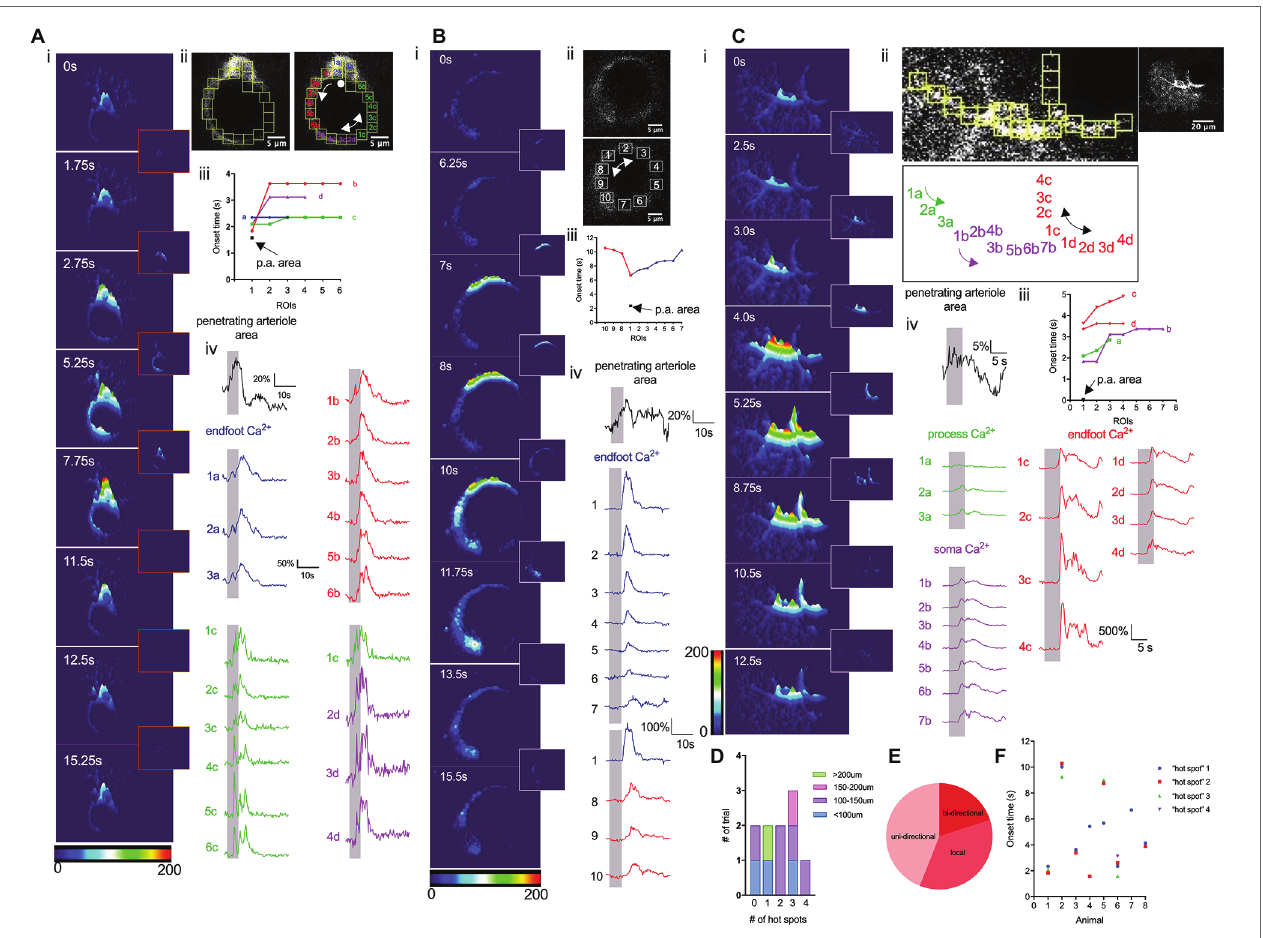
FIGURE 3 | Whisker stimulation elicits discrete endfoot Ca 2+ signals that subsequently spread. (A) Detailed analysis of Ca 2+ dynamics in response to a 5 s whisker stimulation. (i). 3-D surface plot of astrocyte Ca 2+ fluctuations in an astrocyte at different time points immediately prior to (0 s), during (1.75 s, 2.75 s), or after (5.25 s, 7.75 s, 11.5 s, 12.5 s, and 15.25 s) a 5-s whisker stimulation. Insets showed the differential images between the two time points. (ii) Higher magnification image of an endfoot and consecutive ROIs from which Ca 2+ measurements were obtained. Double-headed arrow indicates the bidirectional spread of the Ca 2+ “hot spot” spread. Single-headed arrow indicates the uni-directional spread of the Ca 2+ “hot spot”. A dot indicates Ca 2+ signals remain localized. (iii) Onset times from different ROIs showing regional Ca 2+ activity and vasodilation. (iv) Penetrating arteriole cross-sectional area trace (black) and Ca 2+ traces (colors) from different ROIs. Vertical shaded areas indicate periods of whisker stimulation. (B) Detailed analysis similar to that in A, but from a different animal displaying only the endfoot enwrapping a penetrating arteriole. (i) 3-D surface plot of astrocyte Ca 2+ fluctuations at different time points immediately prior to (0 s) and after (6.25 s, 7 s, 8 s, 10s, 11.75 s, 13.5 s, and 15.5 s) a 5 s whisker stimulation. Insets showed the differential images between the two time points. (ii) Higher-magnification image of the endfoot and consecutive ROIs (right) from which Ca 2+ measurements were obtained. Double-headed arrow indicates bidirectional spread of the Ca 2+ “hot spot”. (iii) Onset times from different ROIs showing endfoot Ca 2+ activity and vasodilation. (iv) Penetrating arteriole cross-sectional area trace (black) and Ca 2+ traces (colors) from different ROIs. Vertical shaded areas indicate periods of 5 s whisker stimulation periods. (C) Detailed analysis similar to that in (A) and (B) , but from a different animal showing all subcellular compartments of an astrocyte. (i) 3-D surface plot showing astrocytic Ca 2+ fluctuations at different time points immediately prior to (0 s), during (2.5 s, 3 s, and 4 s) and after (5.25 s, 8.75 s, 10.5 s, and 12.5 s) a 5 s whisker stimulation. Insets showed the differential images between the two time points. (ii) Higher-magnification image of an endfoot and consecutive ROIs (top left) from which Ca 2+ measurements were obtained. Labels of all the ROIs (bottom) indicated previously. Double-headed arrow indicates bidirectional spread of the Ca 2+ “hot spot”. Lower magnification image of the entire astrocyte (top right). (iii) Onset times from different ROIs showing regional Ca 2+ activity and vasodilation. (iv) Penetrating arteriole cross-sectional area trace (black) and Ca 2+ traces (colors) from different subcellular compartments. Vertical shaded areas indicate periods of whisker stimulation. (D) Summary showing the number of “hot spots” detected associated with the area of the endfoot. (E) Pie chart showing the percentage of how those “hot spots” spread. (F) Scatter plot of onset time for each “hot spot” from individual